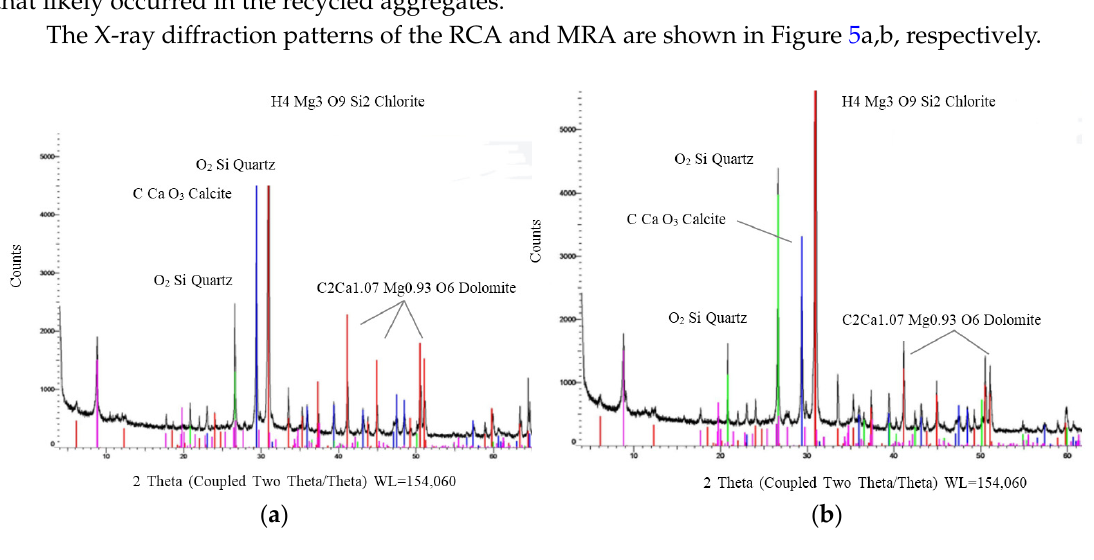
( b ) Figure 6. ( a ) SEM micrograph image of RCA; and ( b ) composition of an RCA sample estimated by X ‐ ray spectroscopy.